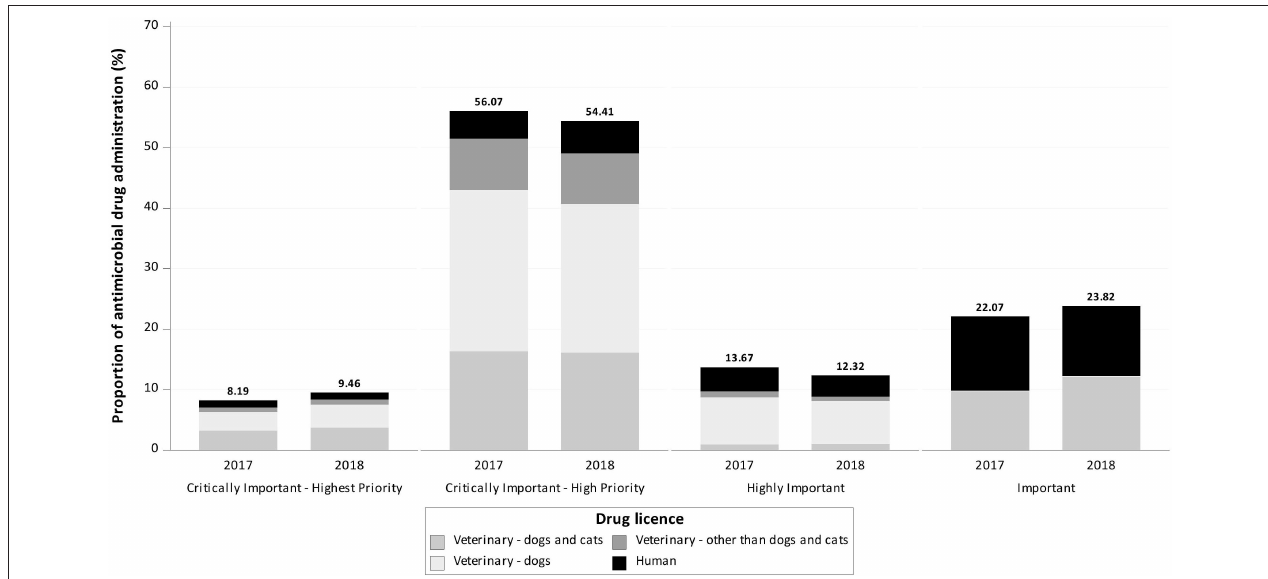
FIGURE 2 | Proportion of documented antimicrobial drug administrations reported to be used in dogs in 2017 and 2018 at the Clinic for Small Animals, University of Veterinary Medicine Hannover, by drug license type and World Health Organization